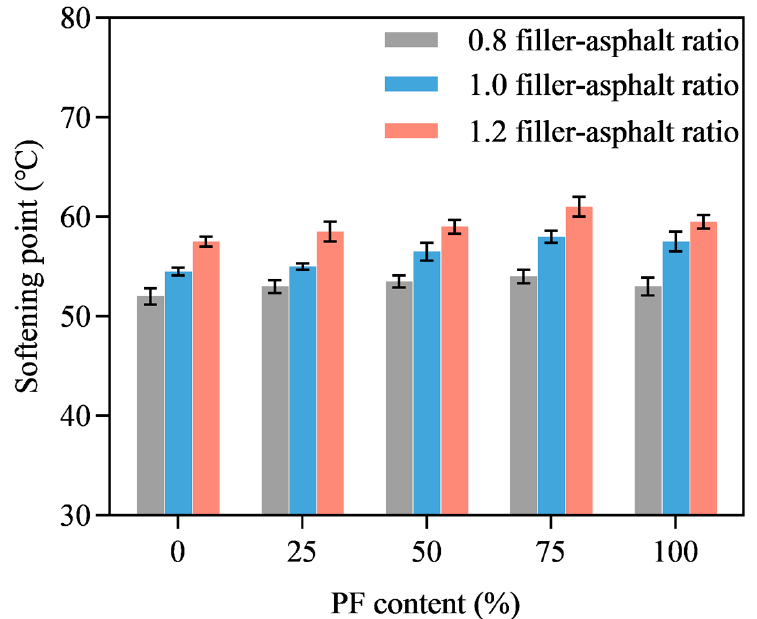
Figure 10. Softening